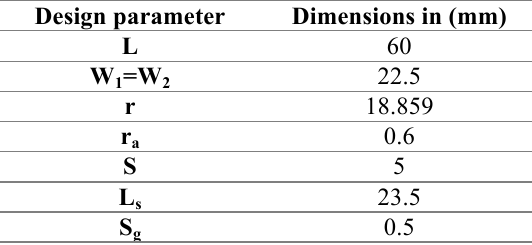
Figure 2: Simulated S of the different geometrical 21 dimensions of ESRR Using HFSS.